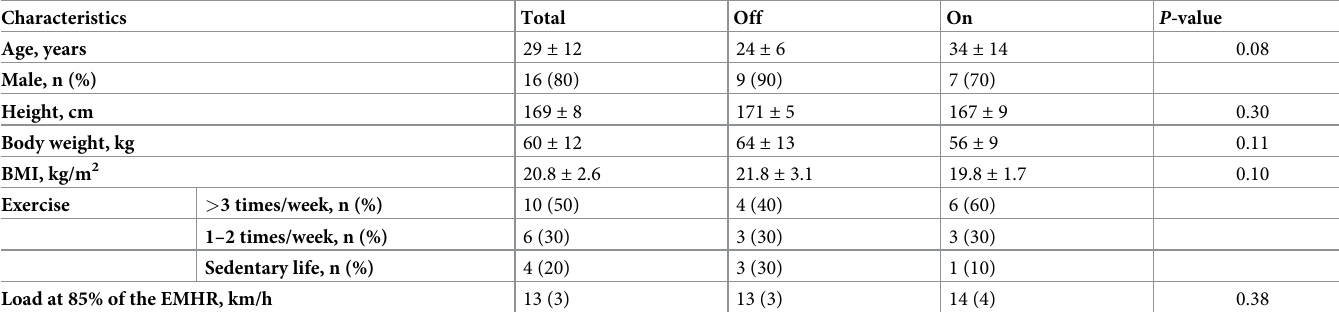
Table 1. Baseline characteristics of